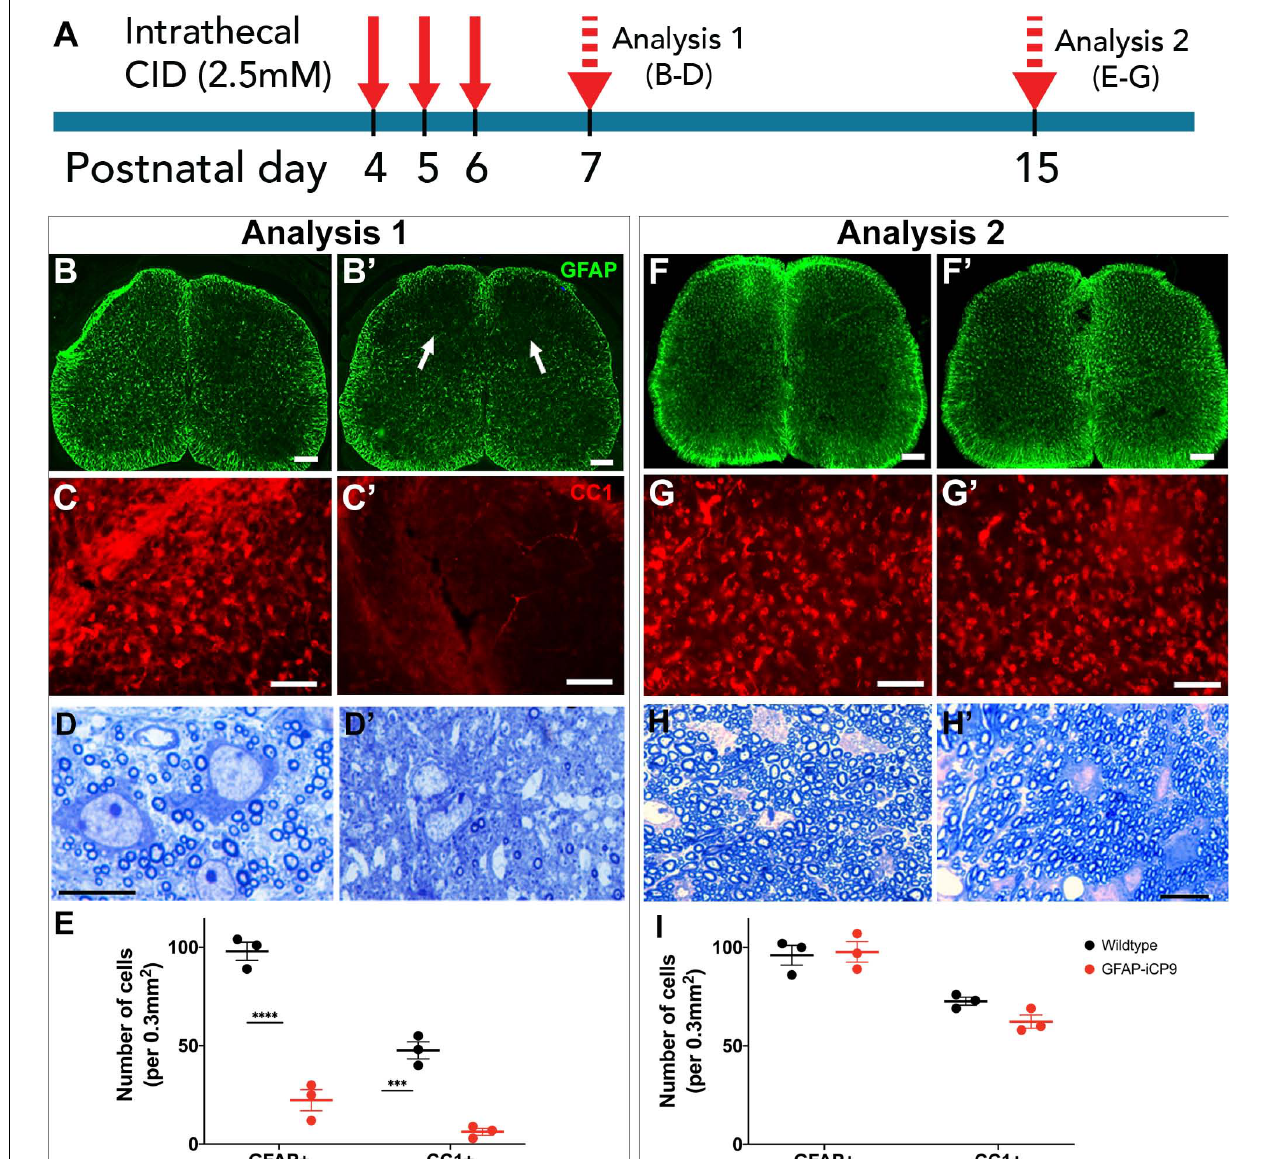
FIGURE 3 | Astrocyte loss compromises spinal cord myelination. (A) Experimental design. Daily intrathecal injections of CID to T11/13 segments of spinal cord were delivered on postnatal days 4,5,6 and the animals analyzed on postnatal days 7 (analysis 1) and 15 (analysis 2). (B) On p7, compared to controls (B) CID treatment significantly reduced the expression of GFAP (B’) . (C) Compared to controls (C) , CID treatment also significantly reduced the number of CC1+ oligodendrocytes (C’) . (D) Toluidine blue stained plastic 1 µ m thick sections confirmed a reduction of myelination compared to controls (D) following CID induced loss of astrocytes at p7 (D’) . (E) Quantification of the relative density of GFAP+ and CCI+ cells in WT and CID treated GFAP- iCP9 spinal cords at P7. (F,G) The cell loss was transient and at P15 the number of GFAP+ astrocytes and CC1+ oligodendrocytes was essentially indistinguishable between control (F,G) and CID treated (F’,G’) regions of GFAP-iCP9 tissue. (H) Myelination recovers to control levels (H) at P15 (H’) following cessation of CID treatment at P6. (I) Quantification of the relative density of GFAP+ and CCI+ cells in WT and GFAP- iCP9 spinal cords at P15. Data represent mean number of cells ± SEM. Two-way ANOVA with Sidak’s multiple comparisons test. **** indicates p < 0.0001. Scale bars: (B,F) 100 µ m; (C,G) 85 µ m; (D,H) 20 µ